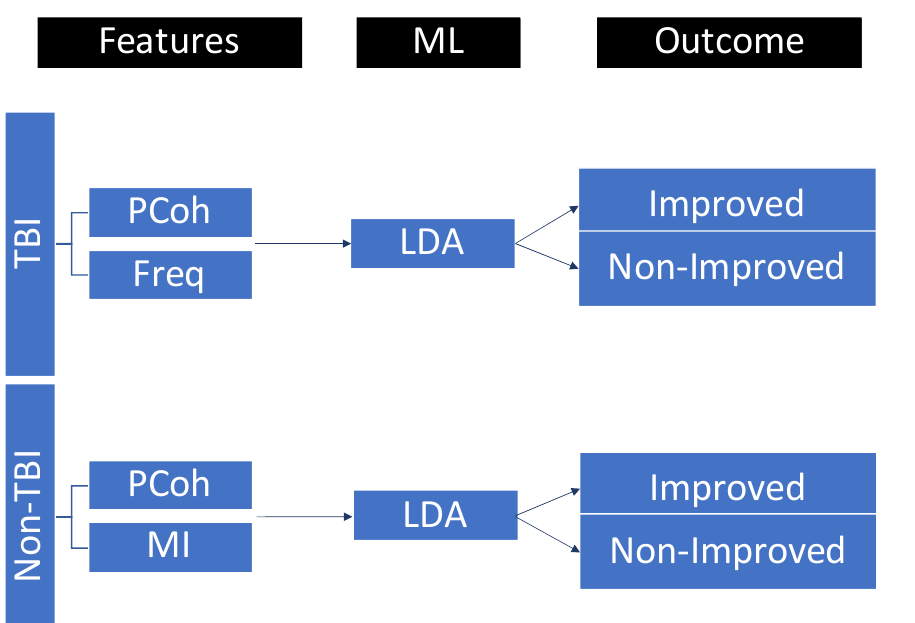
Figure 3. EEG features selected for traumatic (TBI) and nontraumatic (non-TBI) patients and included in the linear discriminant analysis (LDA) for clinical outcome prediction. LDA parameters were as follows: discriminant type = diagLinear (all classes had the same diagonal covariance matrix), gamma = 1, and delta = 0. PCoh = partial coherence, Freq = dominant frequency, MI = mutual information, ML = machine learning.